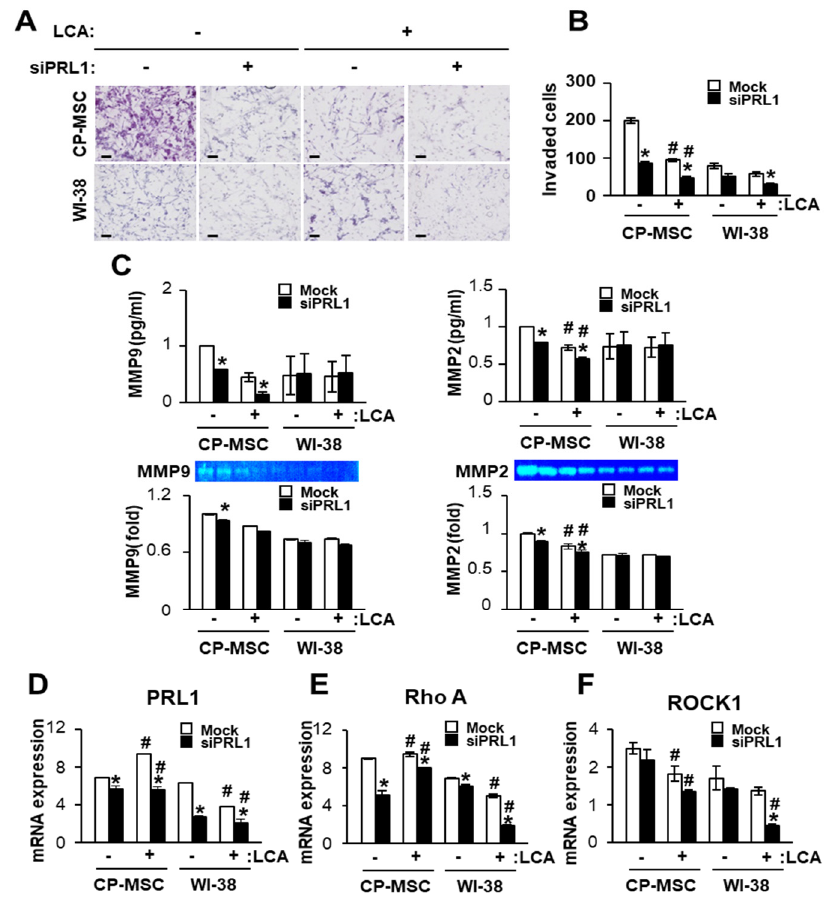
Figure 5. PRL ‐ 1 regulates CP ‐ MSC migration into damaged rat hepatocytes through MMPs and the Rho family in vitro system. ( A ) Images and ( B ) quantification of invading CP ‐ MSCs or WI ‐ 38 cells in the transwell insert system co ‐ cultured with rat primary hepatocytes treated or untreated with siRNA ‐ PRL ‐ 1 after 12 h of treatment with or without LCA. The invading cells were counted. The scale bar represents 100 μ m. ( C ) Enzyme activities of MMP ‐ 9 and MMP ‐ 2 in conditioned media collected from the transwell insert system treated with or without siRNA ‐ PRL ‐ 1 after 12 h of treatment with or without LCA by ELISA (upper channel) and zymography (down channel). Each bar represents the fold changes in MMP ‐ 9 and ‐ 2 expression compared with the siRNA ‐ PRL ‐ 1 and LCA non ‐ treated group. mRNA levels of ( D ) PRL ‐ 1, ( E ) Rho A, and ( F ) ROCK1 in invading CP ‐ MSCs or WI ‐ 38 cells from the upper chamber to the lower chamber after treatment with or without siRNA ‐ PRL ‐ 1 toward rat primary hepatocytes treated with or without LCA. Total RNA from the invading cells in each group was pooled. Each experiment was repeated at least three times. The data are expressed as the mean ± SEM (* p < 0.05 compared with siRNA ‐ PRL ‐ 1treatment group; # p < 0.05 compared with the LCA treatment group). siPRL1, siRNA ‐ PRL1; LCA, lithocholic acid.